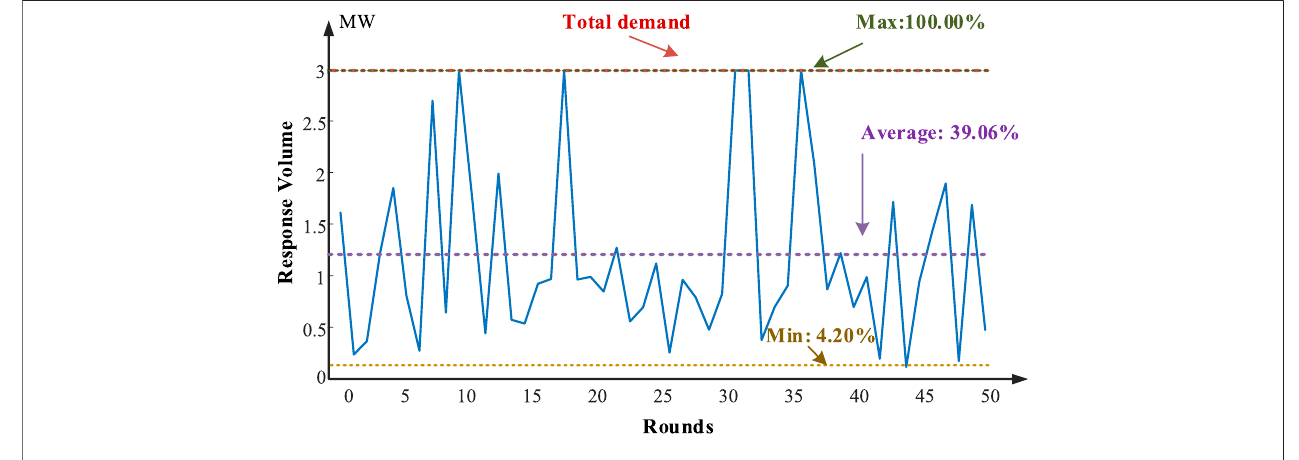
FIGURE 15 | Response results of 50 rounds without the